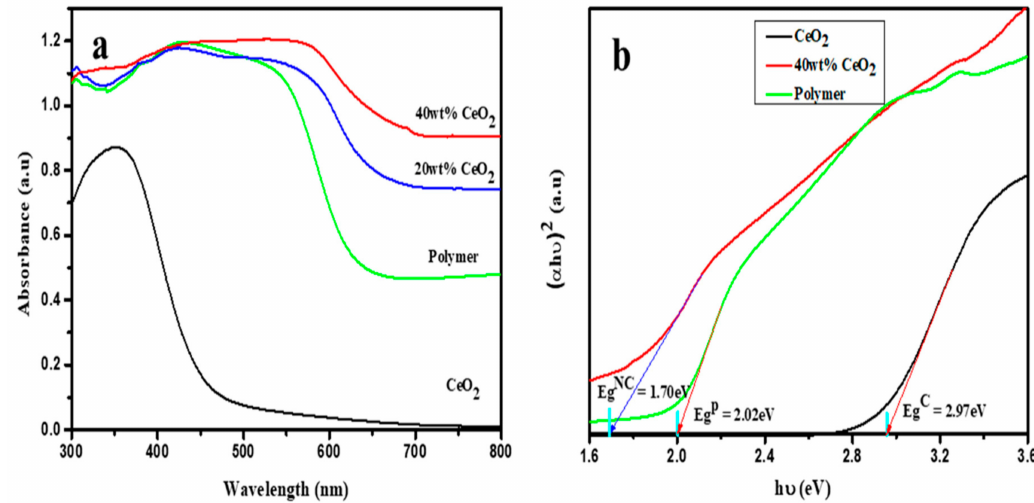
Figure 5. ( a ) Ultraviolet–visible (UV–Vis) spectra of CeO 2 , polymer, polymer composite with 20 wt% and 40 wt% CeO 2 nanoparticles. The determination of band gap is shown in ( b